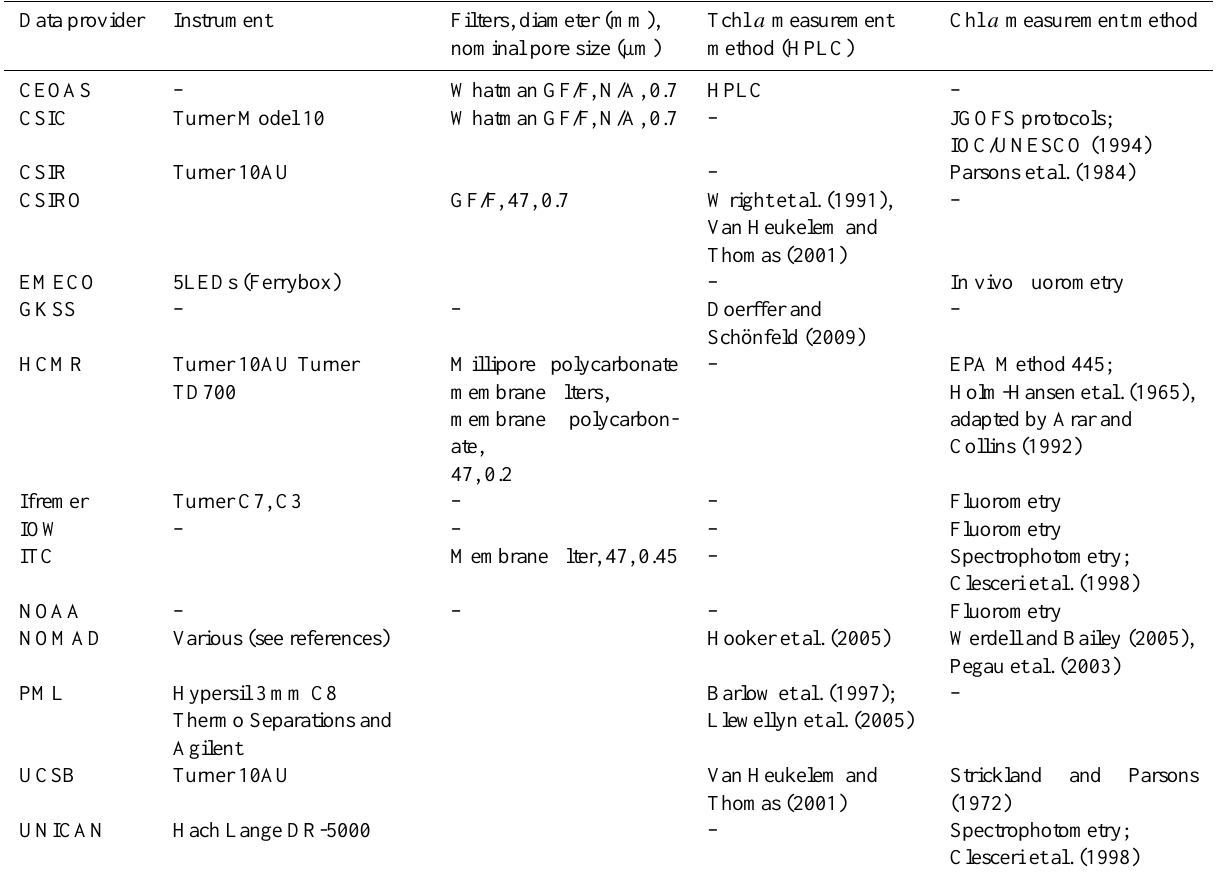
Table 4. Instrument and methods of chlorophyll a measurement in the CCRR match-up data set. Data